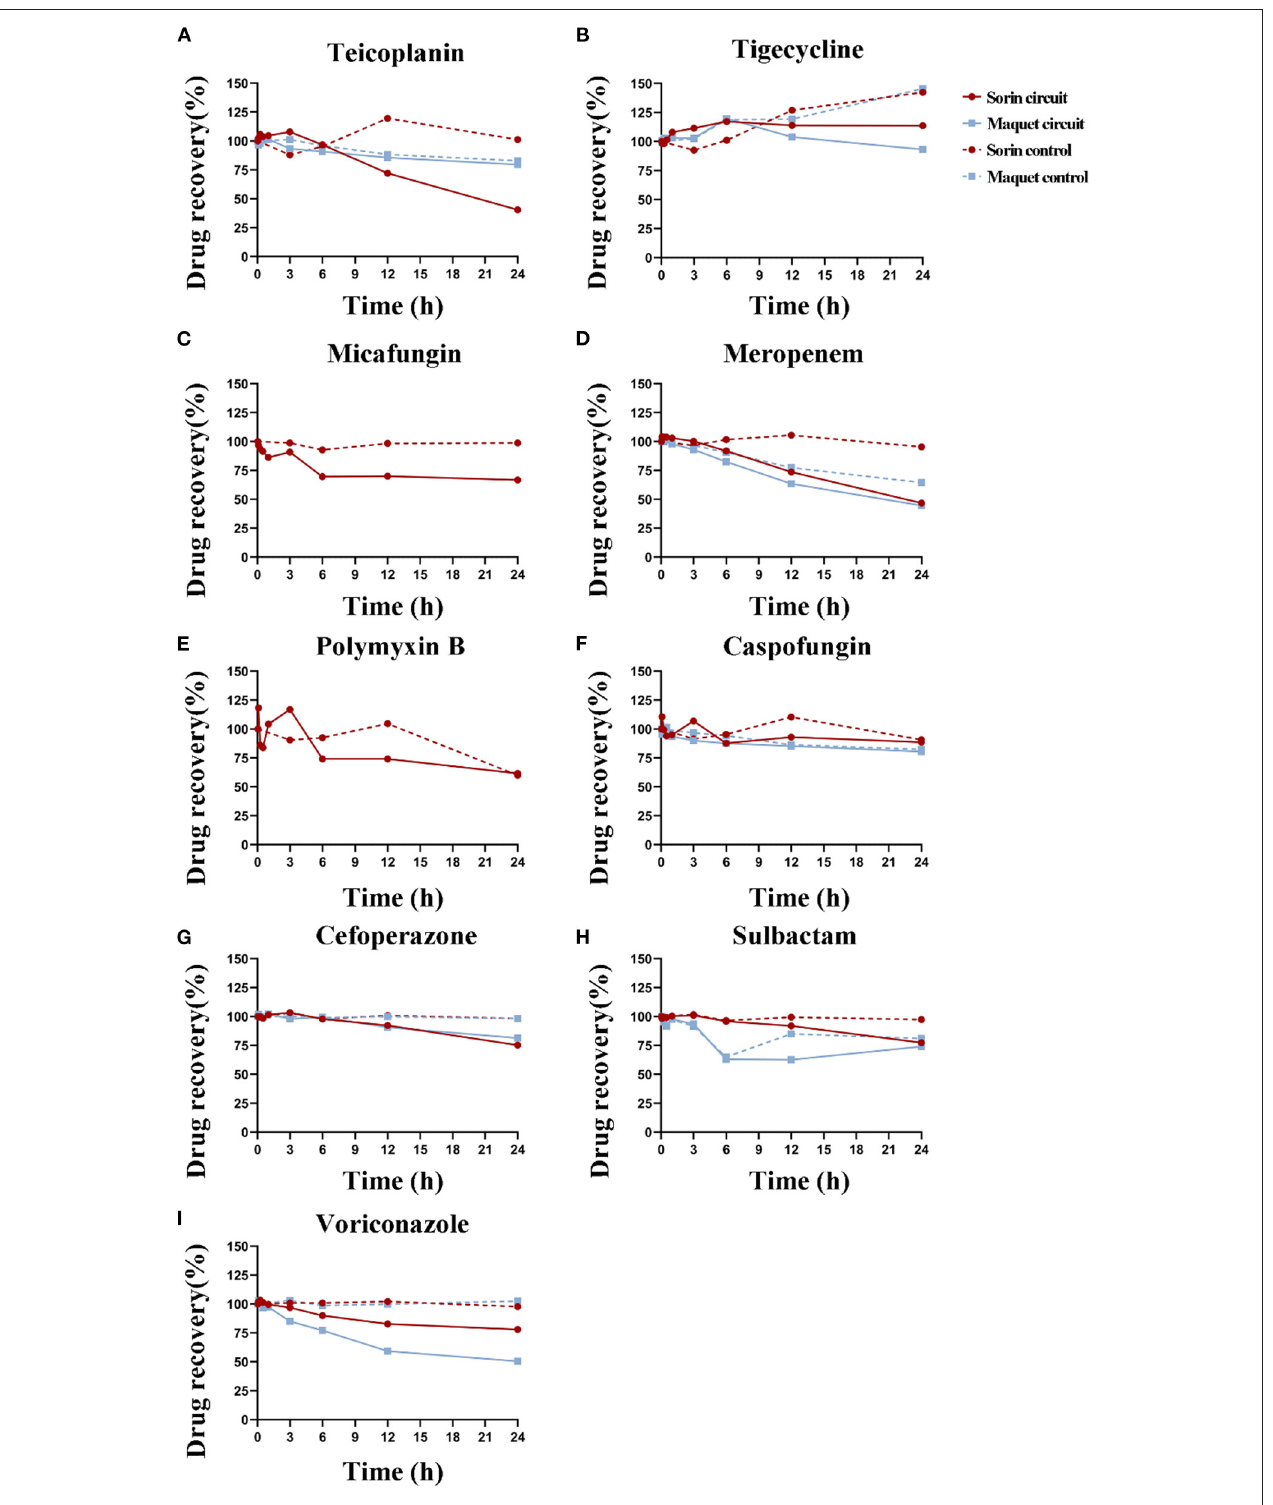
FIGURE 2 | Durg recovery of experimental drugs at different time points in Sorin and Maquet ECMO circuits and corresponding control groups. Average drug recovery vs. time for (A) teicoplanin, (B) tigecycline, (C) micafungin, (D) meropenem, (E) polymyxin B, (F) caspofungin, (G) cefoperazone, (H) sulbactam, and (I) voriconazole in the Maquet (blue) and Sorin (red) circuits and corresponding control groups.